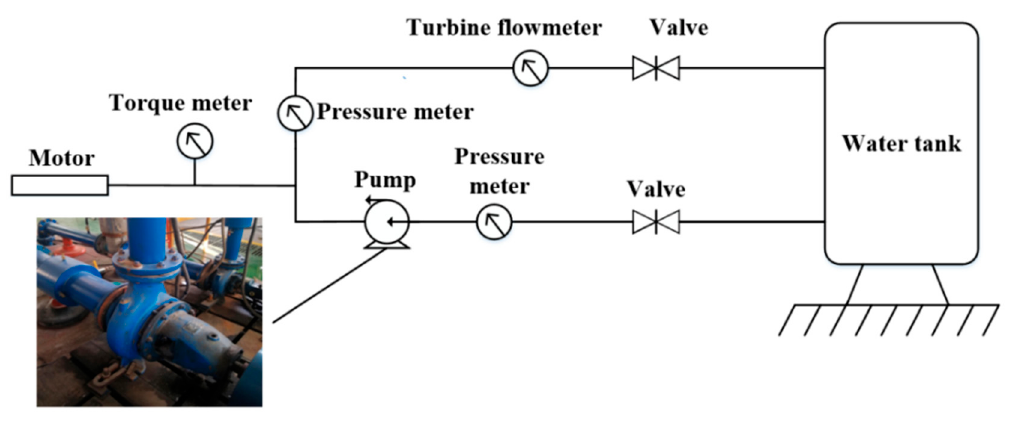
Figure 3. Hydraulic performance test system.